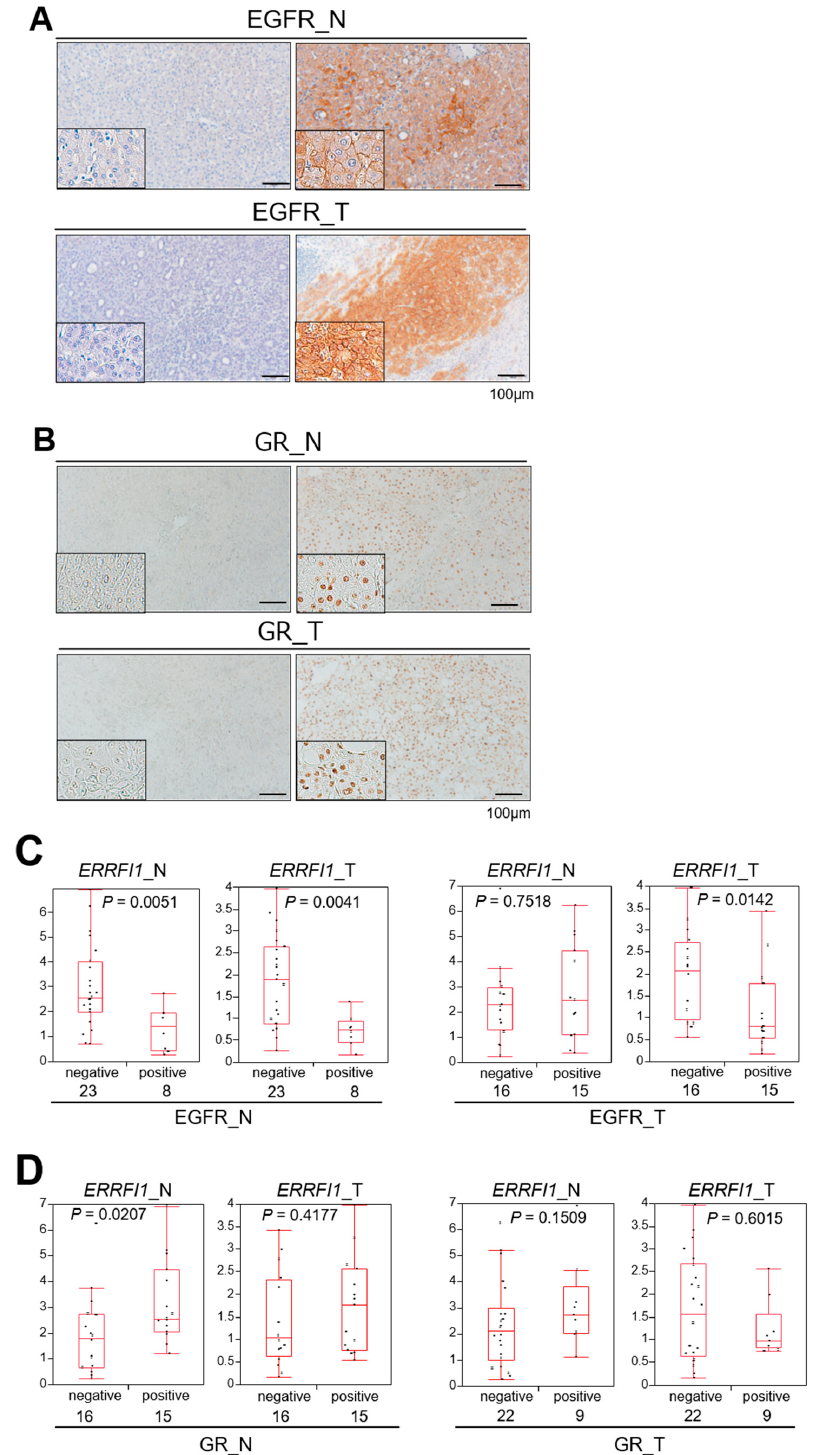
Figure 6. Glucocorticoid receptor (GR) activation and ERBB receptor feedback inhibitor 1 ( ERRFI1 ) expression are inversely correlated with epidermal growth factor receptor (EGFR) expression in human hepatocellular carcinoma (HCC). ( A , B ) Representative images of EGFR (A) and glucocorticoid receptor (GR; B) immunohistochemistry of non-tumor HCC adjacent tissue (N: left panels) and HCC (T: right panels). All samples were obtained via surgical resection in patients diagnosed with HCC. ( C , D ) Correlation between ERRFI1 mRNA expression and positivity for EGFR (C) or GR (D) in non-tumor (N) and tumor (T) tissues. Each box plot depicts the median and quartiles. Whiskers indicate the furthest point within 1.5 × the interquartile range (the third quartile minus the first quartile) from the